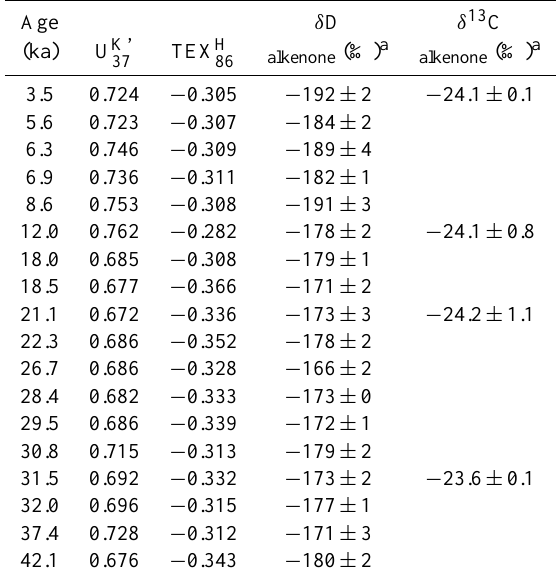
Table 2. Results for combined C 37 : 2 − 3 alkenone stable hydrogen isotope ( δ D alkenone ,‰), stable carbon isotope ( δ 13 C alkenone